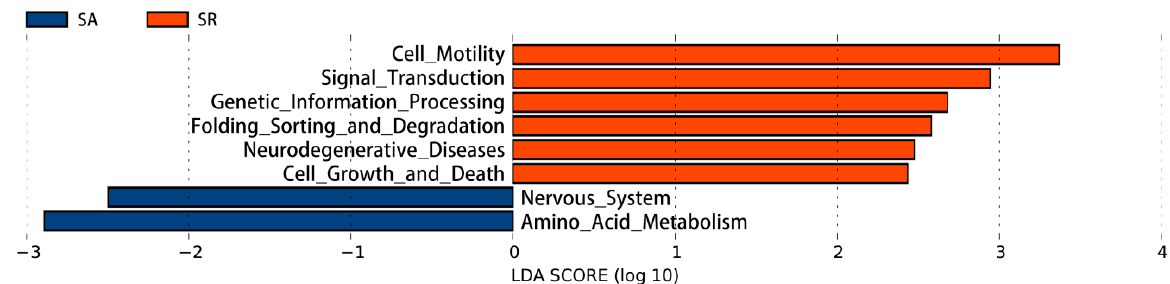
Figure 5. Differences in gut microbial function prediction between the SA and the SR treatments. SA: slow-growing chickens fed ad libitum, SR: slow-growing dual-purpose chickens with feed restriction.